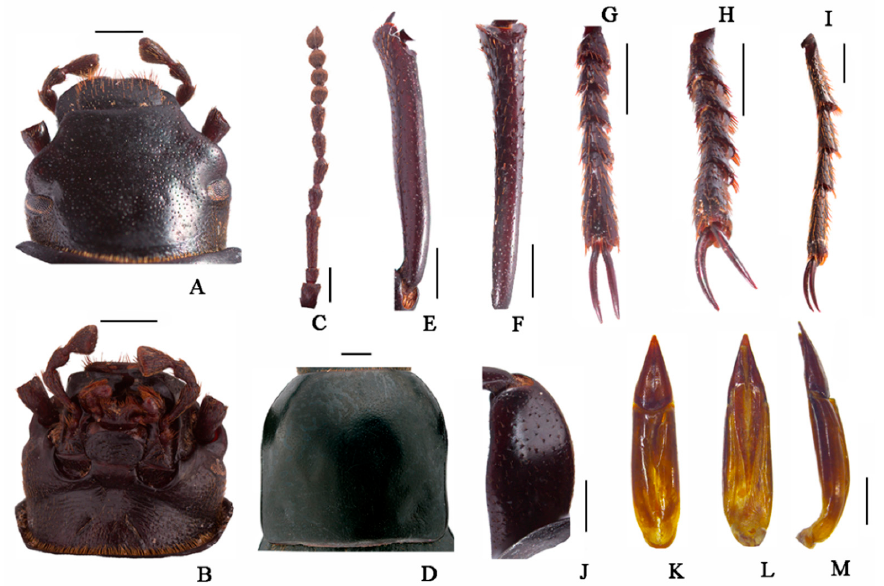
Figure 15. Nalepa ovalifolia sp. n. ( A ) head, dorsal view; ( B ) head, ventral view; ( C ) antenna; ( D ) pronotum; ( E ) protibia; ( F ) mesotibia; ( G ) protarsus; ( H ) mesotarsus; ( I ) metatarsus; ( J ) profemora; ( K – M ) aedeagus: ( K ) dorsal view; ( L ) ventral view; ( M ) lateral view. Scale bars: 1.0 mm.